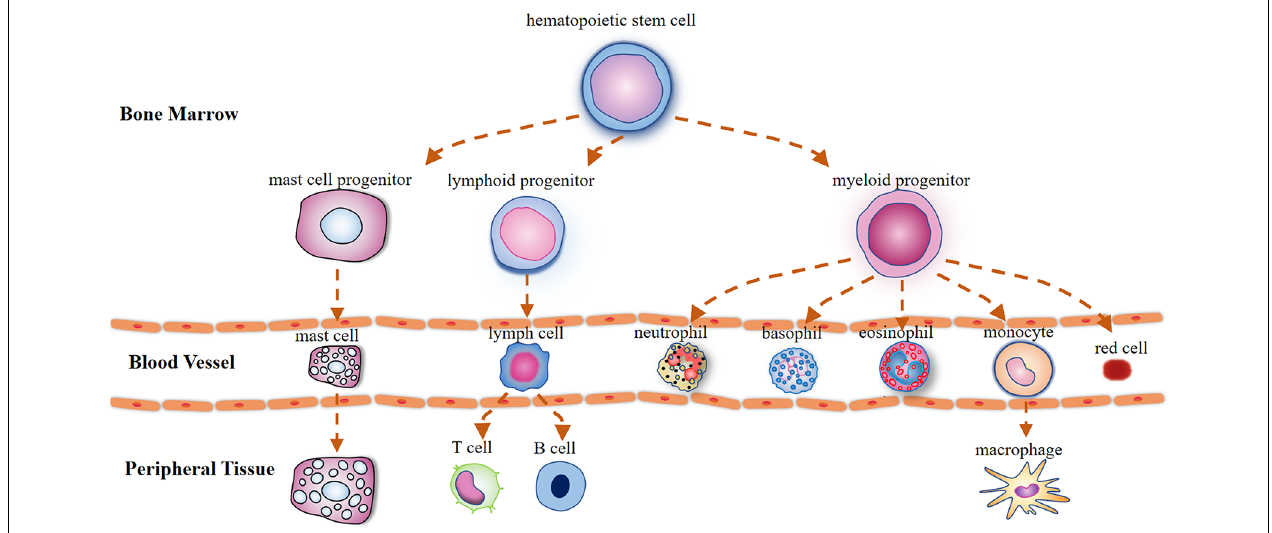
FIGURE 1 | Illustration outlining the mast cells (MCs) differentiation trajectories. Mast cells, lymphocytes, and myeloid cells are derived from pluripotent hematopoietic progenitors in the bone marrow. Unlike basophils that attain their maturity in the circulation, mast cell precursors circulate in the bloodstream as immature cells and are transited out to the peripheral tissues where they mature under the influence of growth